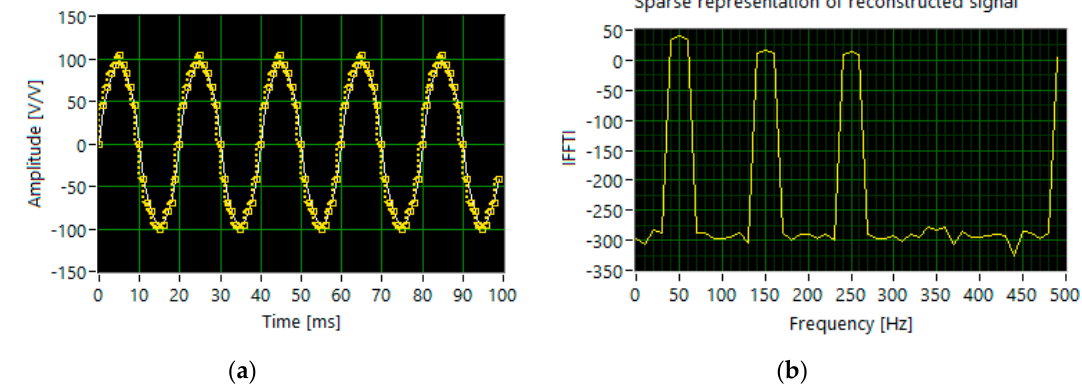
Figure 7. The results of simulation for set 2: ( a ) the segments of time waveforms of the original (white line) and reconstructed signal (dotted yellow line); ( b ) DFT components of the reconstructed signal.